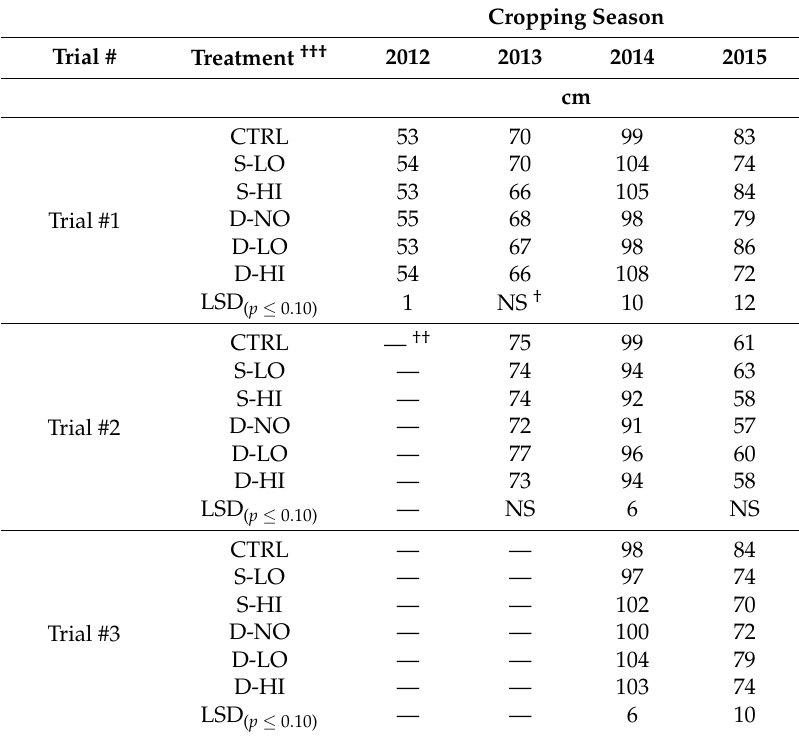
Table 4. Late season soybean plant top heights of lime treated plots for all field trials 2012 to